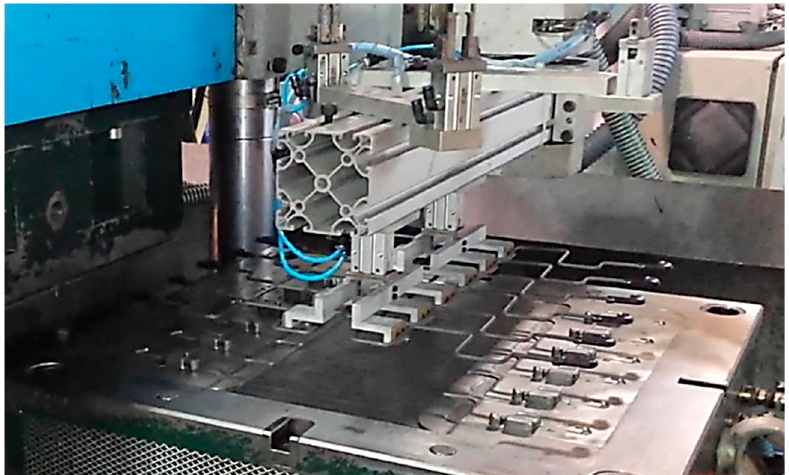
Figure 13. Image of the gripper in action, after implementation.